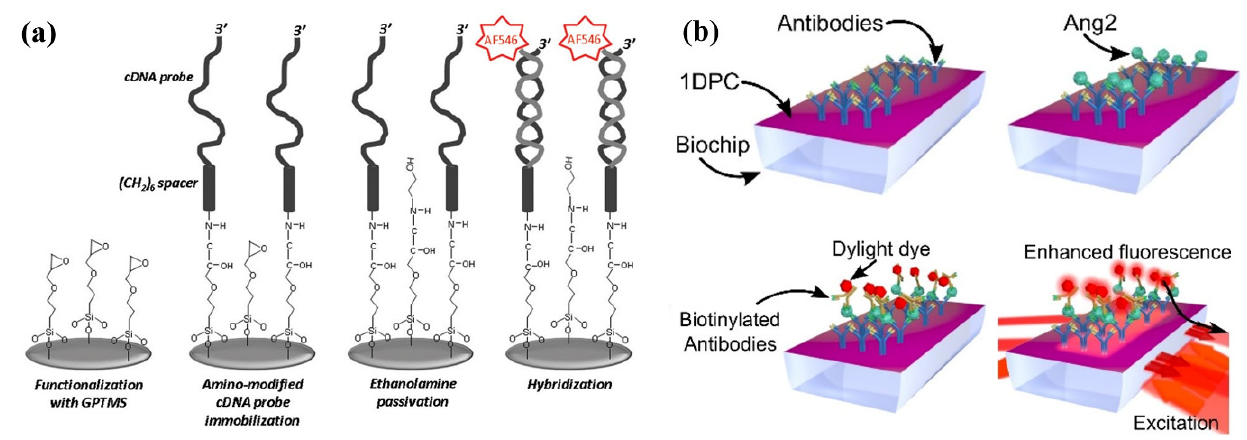
Figure 7. Fluorescence ‐ based one ‐ dimensional (1D) PC ‐ sensing modalities for various biological analytes of interest. ( a ) A 1DPC biochip used to fluorescently detect microRNA, adapted with permission from [178] ( b ) 1DPC biosensor for Angiopoetin ‐ 2 tumor biomarker detection, adapted with